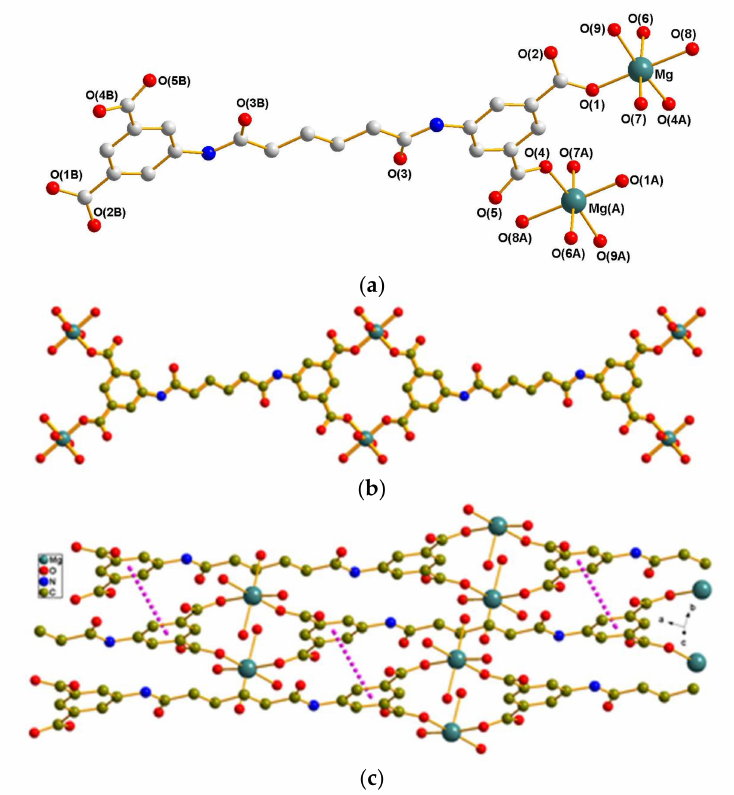
Figure 2. ( a ) Coordination environment of 2 ; Symmetry Code: (A) -x, -y, -z. ( b ) A view showing the 1D structure of 2 . ( c ) A drawing showing π - π interaction in 2 , resulting a 2D